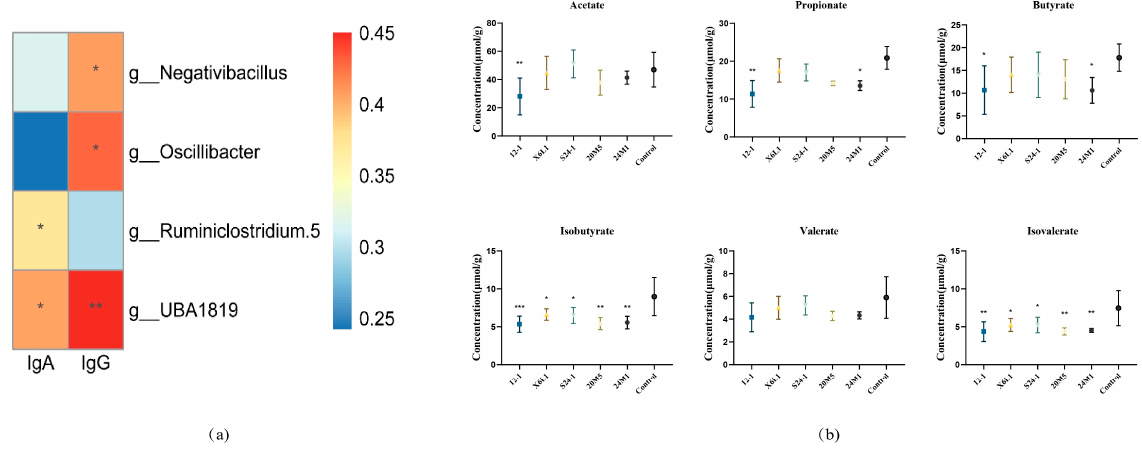
Figure 7. Analysis of L. fermentum on gut microbiota in mice and cecum SCFAs. ( a ) The correlation between IgA, IgG and colonic microbiota. “*” indicates p < 0.05, and “**” indicates p < 0.01 (compared with control group); ( b ) The content of short chain fatty acids in cecum. “*” indicates p < 0.05, and “**” indicates p < 0.01, “***” indicates p < 0.001 (compared with control group).